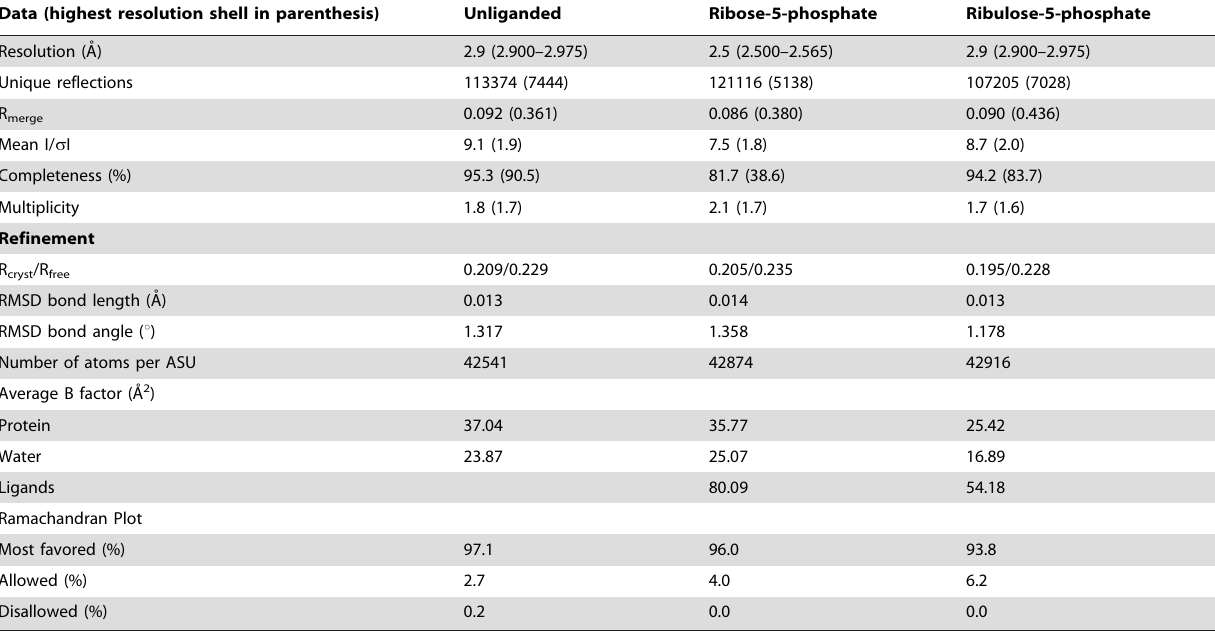
Table 1. Crystallographic data and refinement